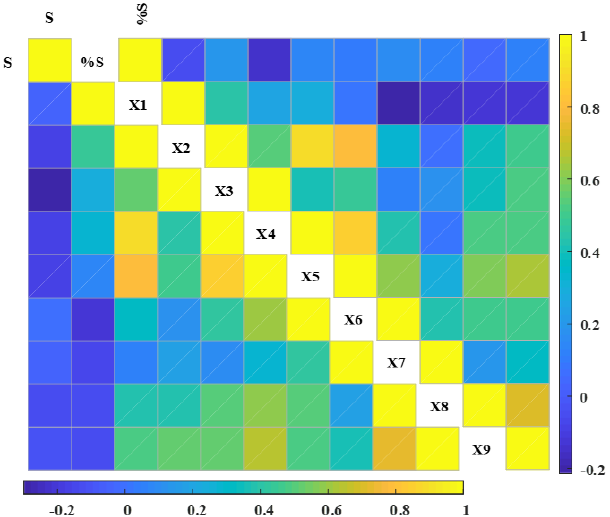
Figure 9. Pearson correlation coefficient based on the association between (1) the magnitude of shifts in the CWSC with multiple climate variables as well as the connection between different cli- mate variables (lower triangular matrix) and (2) the magnitude of percentage shifts in the CWSC with multiple climate variables as well as the connection between different climate variables (upper triangular matrix). Panels (a) and (b) denote a connection between the shift or percentage shift in the CWSC with the climate vari- ables during the periods before and after the change point, respec- tively. Panels (c) and (d) denote the association between the shift or percentage shift in the CWSC with the variation and percentage variation of climate variables of two periods, respectively. Y1–Y24 denotes the climate variables in Table